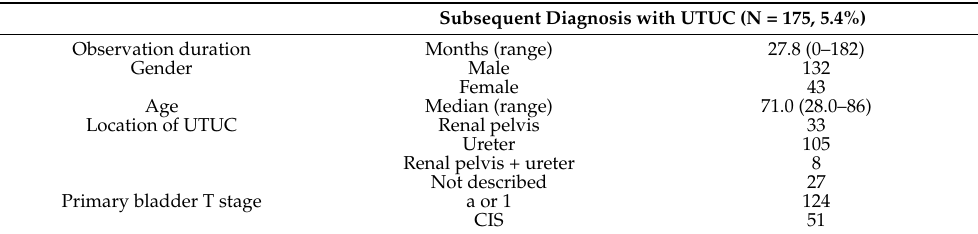
Table 1. Characteristics of patients with subsequent diagnosis with UTUC after BCG bladder instilla- tion